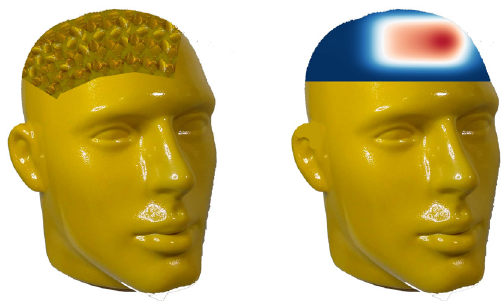
Figure 22: The touch - sensitive interface can be used for gesture and touch recognition in social and sex robots. The touch and the pressure can be measured and used for emotional